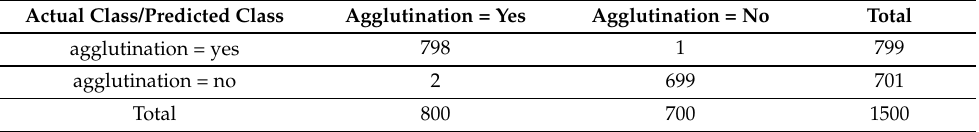
Table 15. Confusion matrix for the optimized ORB algorithm over the 1500 patches.